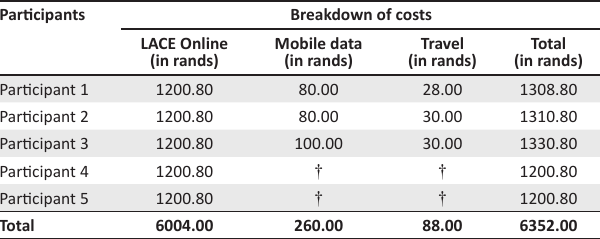
TABLE 7: Breakdown of costs. Participants Breakdown of costs LACE Online Mobile data (in rands) (in